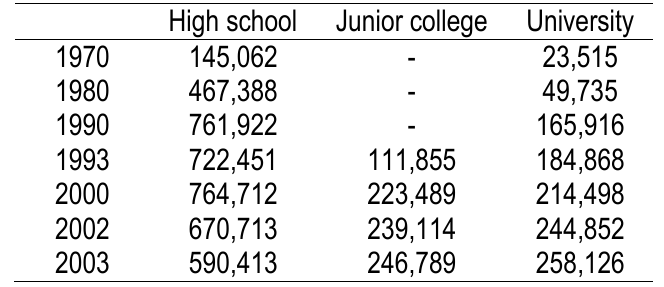
Table 8. Number of the yearly graduates